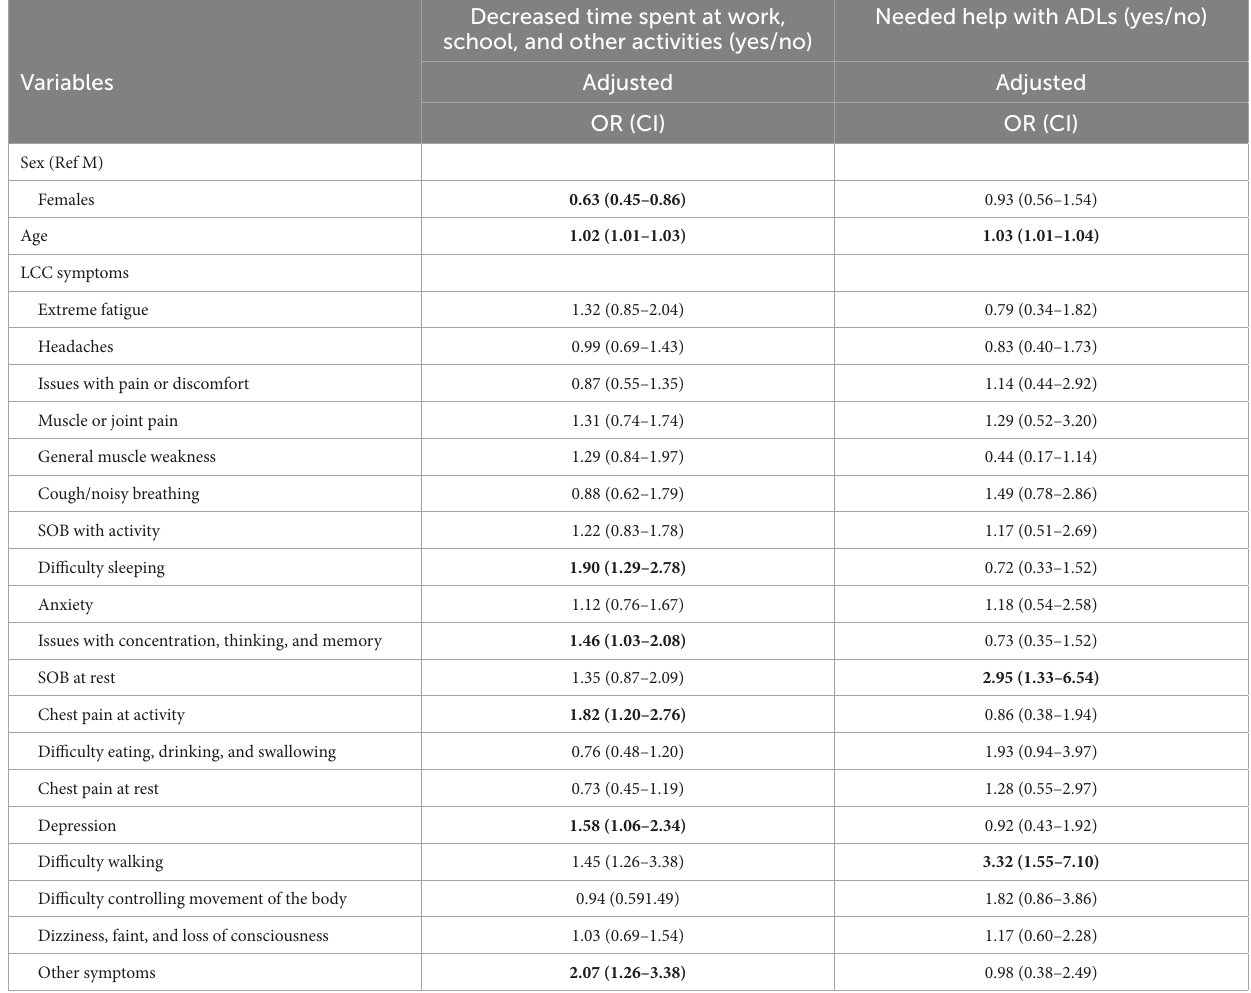
TABLE 4 Factors associated with greater activity limitations in long COVID condition (LCC). Decreased time spent at work, school, and other activities